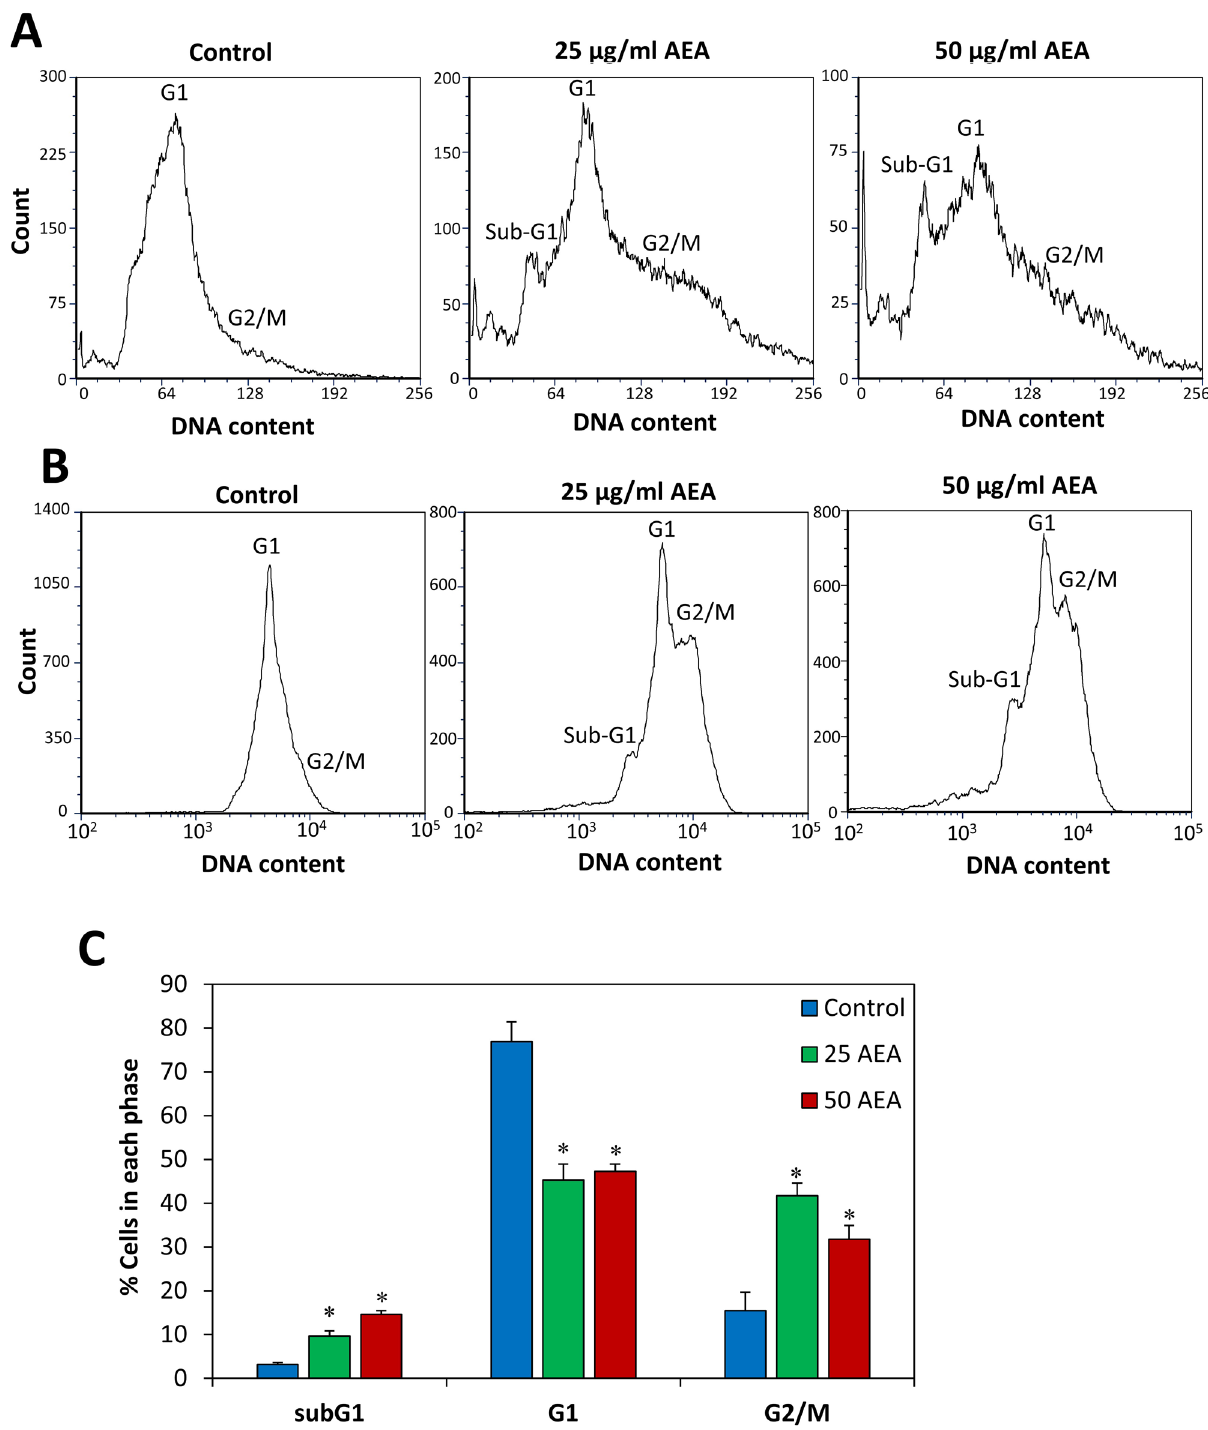
Figure 6. AEA leads to the accumulation of bacteria in the G2/M phase of the cell cycle. ( A , B ) MDRSA CI-M was incubated in the absence or presence of the indicated concentrations of AEA for 2 h, and then fixed with methanol and stained with DAPI. ( A ) The cell cycle read in linear scale. ( B ) The cell cycle read in logarithmic scale. ( C ) The percentage of bacteria in Sub-G1, G1 and G2 as measured from 4 different samples. *p <